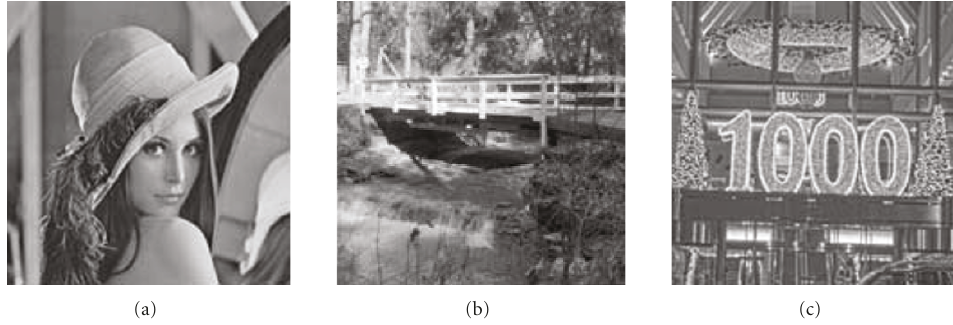
Figure 4: Test Images: Lena, Bridge, and Neon